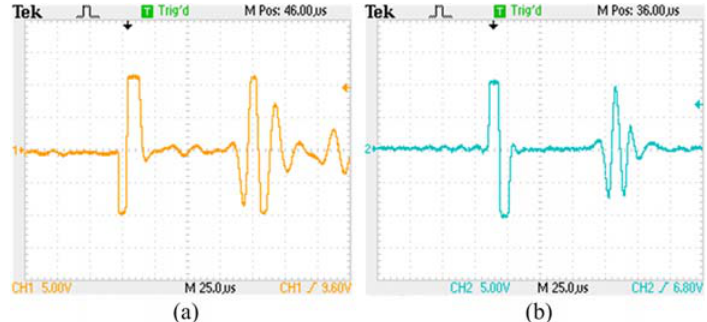
Figure 4. Oscilloscope waveforms of induction signal ( a ) without the compensation coil; ( b ) with the compensation coil.